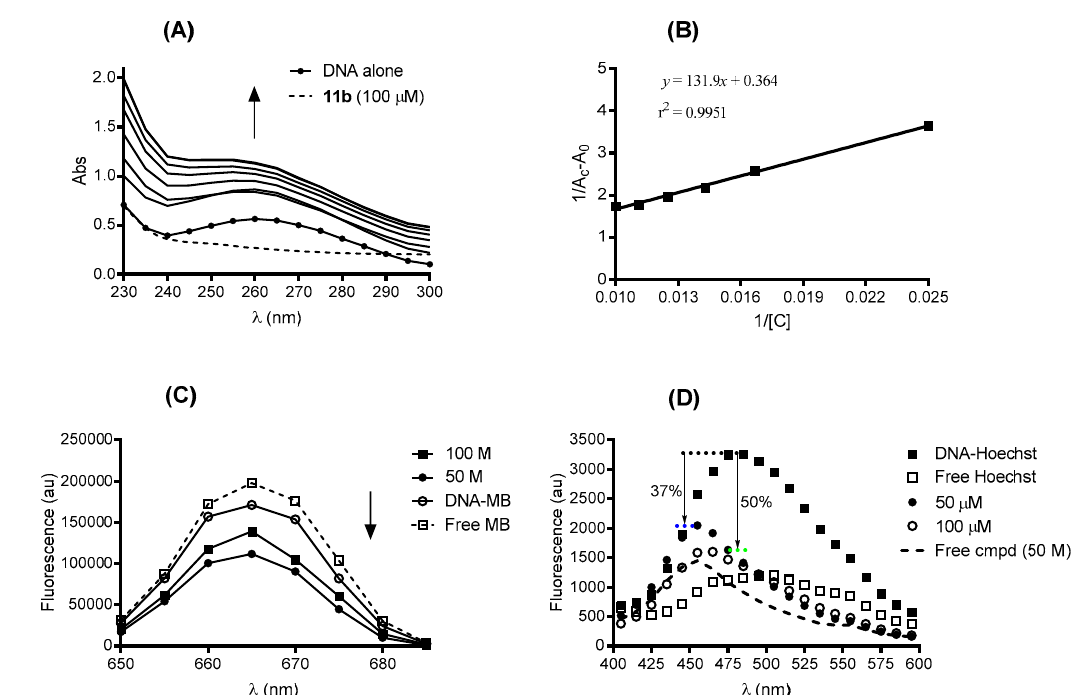
Figure 4. DNA binding affinity results of compound 11b with calf thymus DNA. ( A ) UV-Vis DNA titration curve, ( B ) guest-host reciprocal plot of the UV-Vis DNA titration experiment, ( C ) competitive DNA intercalation assay using methylene blue (MB) and ( D ) Hoechst assay results for competitive DNA minor groove binding.